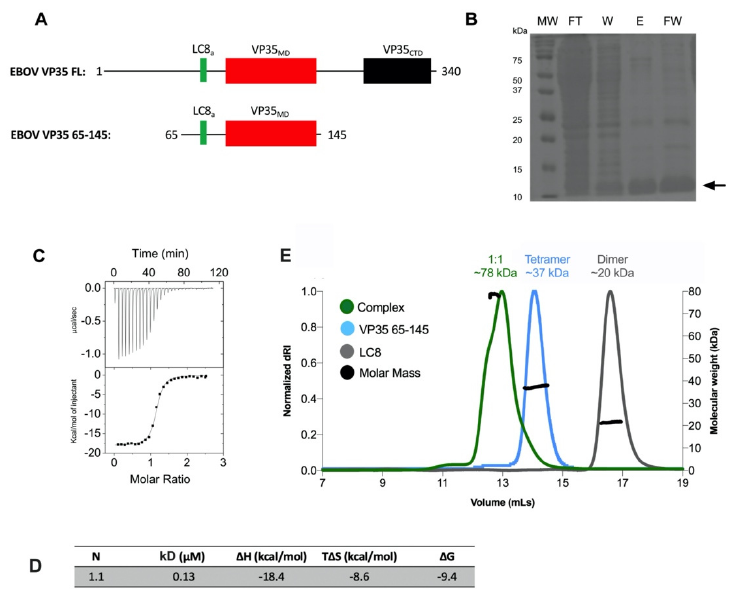
Figure 5. Zaire Ebolavirus phosphoprotein VP35 construct associated stronger to LC8 and had a similar oligomerization state to P MDL . ( A ) Domain organization and construct design of VP35 and VP35 65–145, respectively. Black lines, disordered chains; red rectangles, VP35 multimerization do- main; black rectangles, VP35 C-terminal domain; green rectangles, LC8 binding anchor (LC8 a ). ( B ) Purification of VP35 65–145 using TALON affinity nickel resin and a hexa-histidine N-terminal tag on P MDL . MW, molecular weight; FT, flow-through; W, wash; E, elution in 350 mM imidazole; FW, final wash in 350 mM imidazole. ( C ) Isothermal titration calorimetry analysis of VP35 and LC8 in- teraction at 25 °C. 15 μ M of VP35 in the calorimeter cell was titrated with 20 injections of 195 μ M LC8. ( D ) ITC parameters from the best generated fit. ( E ) Multi-angle light scattering of VP35 45–165, LC8, and the complex at 100 μ M and a 1:1 ratio, respectively. dRI, refractive index. 4. Discussion We showed that an essential, multifunctional HPIV polymerase cofactor, phospho- protein HPIV3 P, is a thermostable, primarily tetrameric coiled-coil. Our study also demonstrates that among paramyxoviruses there are different modes of phosphoprotein- LC8 interactions, and that associated mechanisms may diverge even within closely related